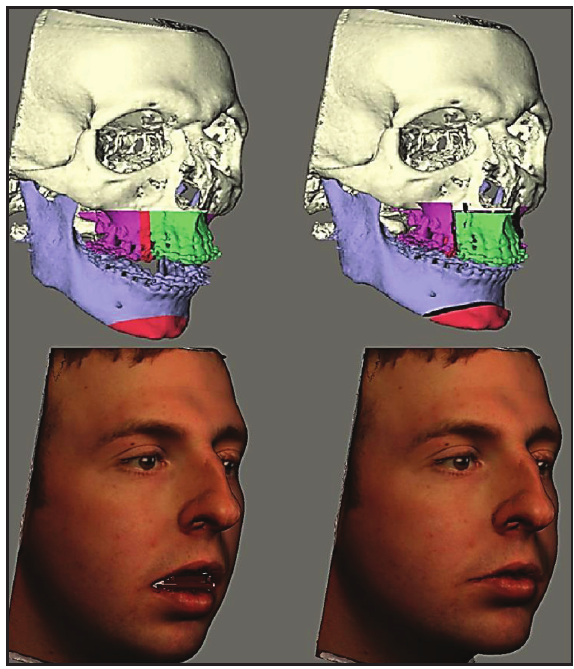
Figure 6. Final virtual 3D combined skeletal and soft tissue prediction